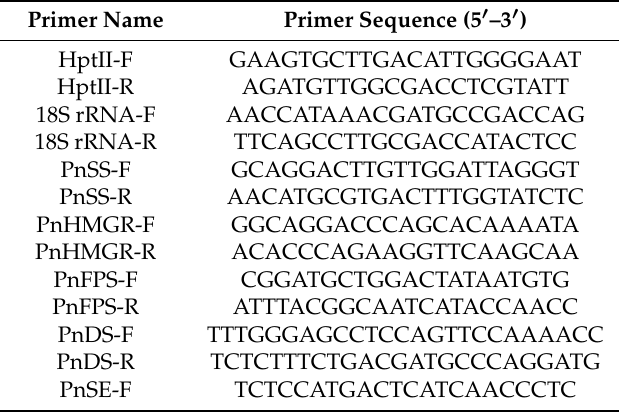
Table 1. Sequences of the primers used in this